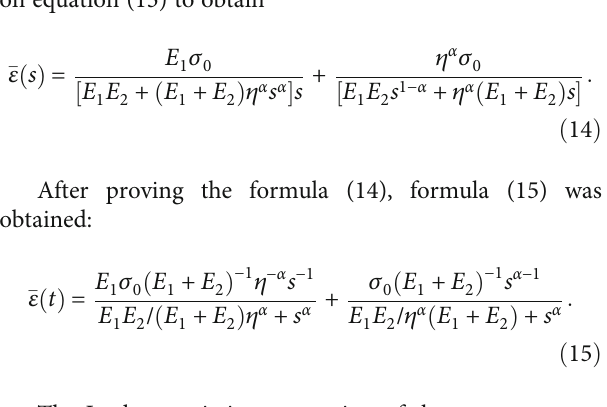
Figure 4: Fractional Poynting-Thomson